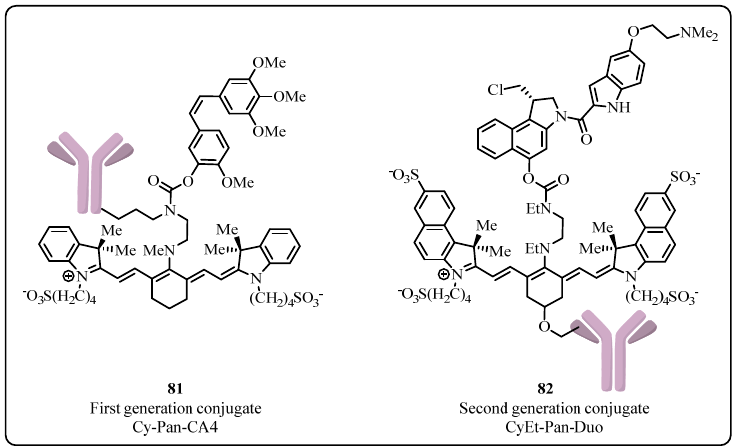
Figure 10. First and second generations of ADC containing cyanine photocage linkers.